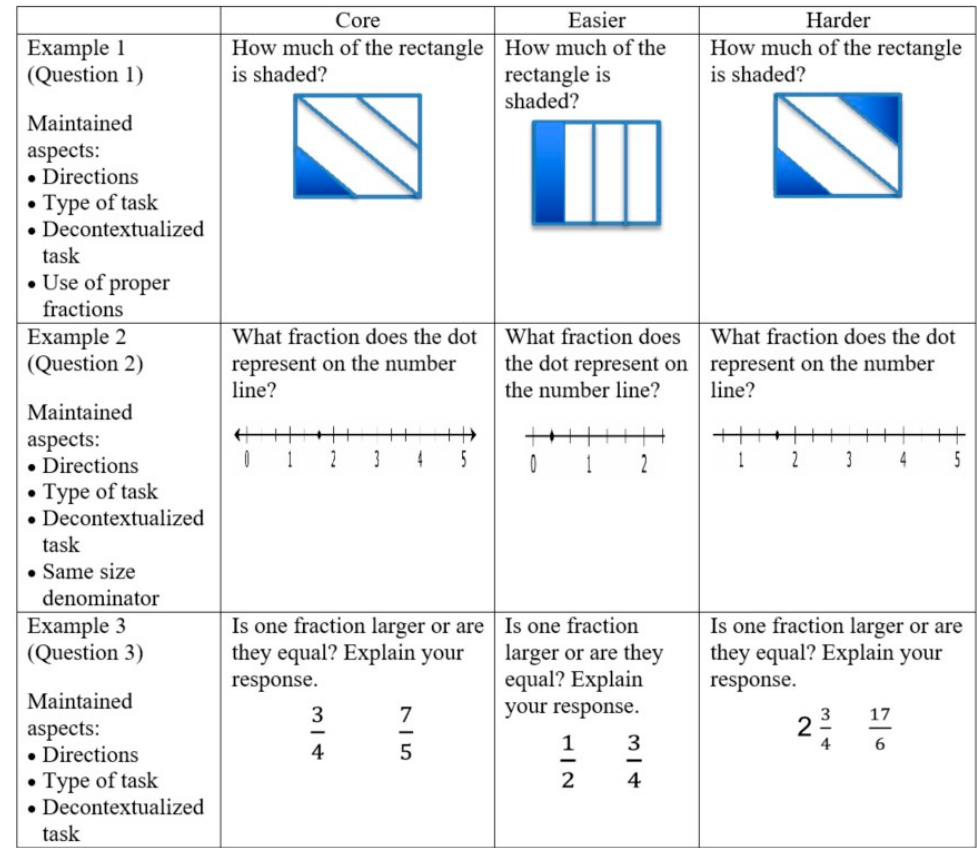
Figure 3. Maintained aspects of assessment items. Table 4. Maintained aspects for Questions 1, 2, and